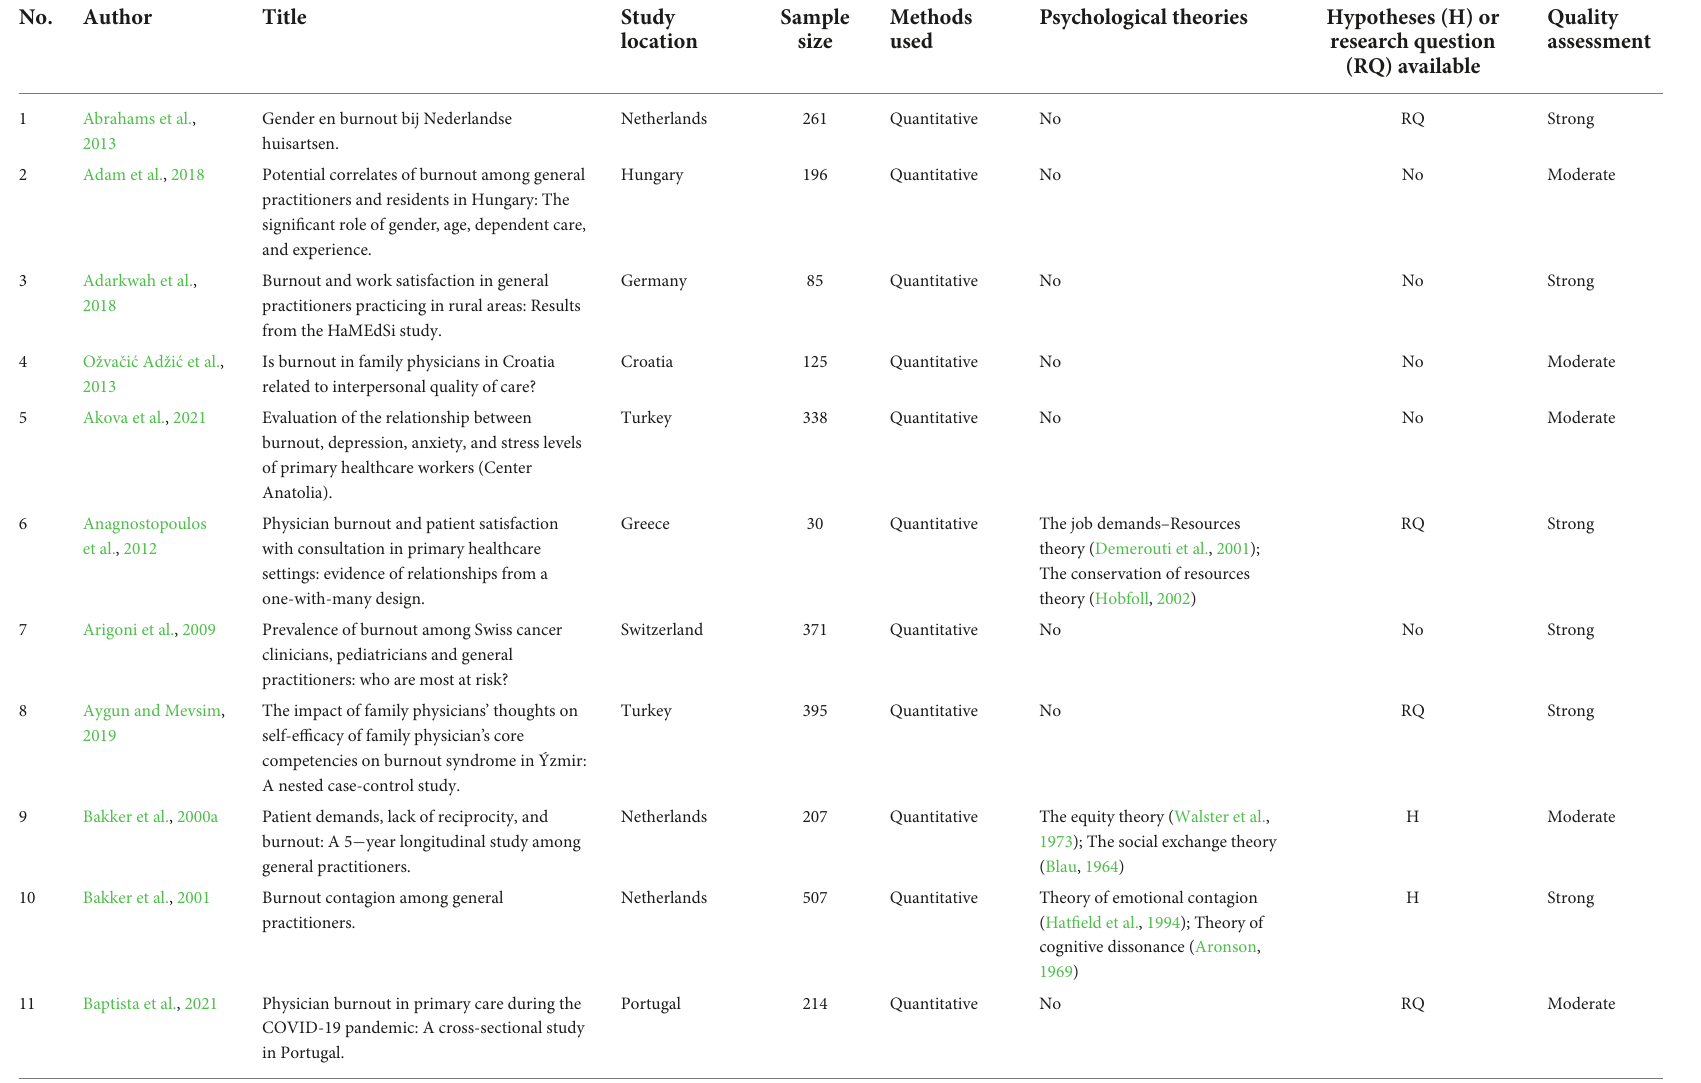
TABLE 1 Results of the systematic quantitative literature review (details of documents included in the data